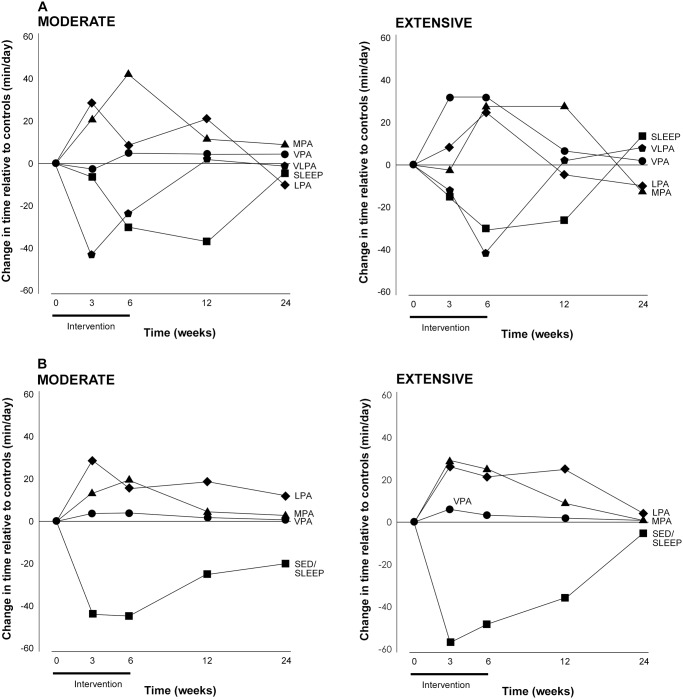
Changes in time (min/d) relative to Controls, from baseline to 6 months follow-up in time spent by the Moderate (left panel) and Extensive (right panel) groups in the different energy expenditure zones according to MARCA recalls (panel A) and accelerometry (Panel B).
Note: SED/SLEEP = sedentary/sleep, VLPA = very light physical activity, LPA = light physical activity, MPA = moderate physical activity, VPA = vigorous physical activity.